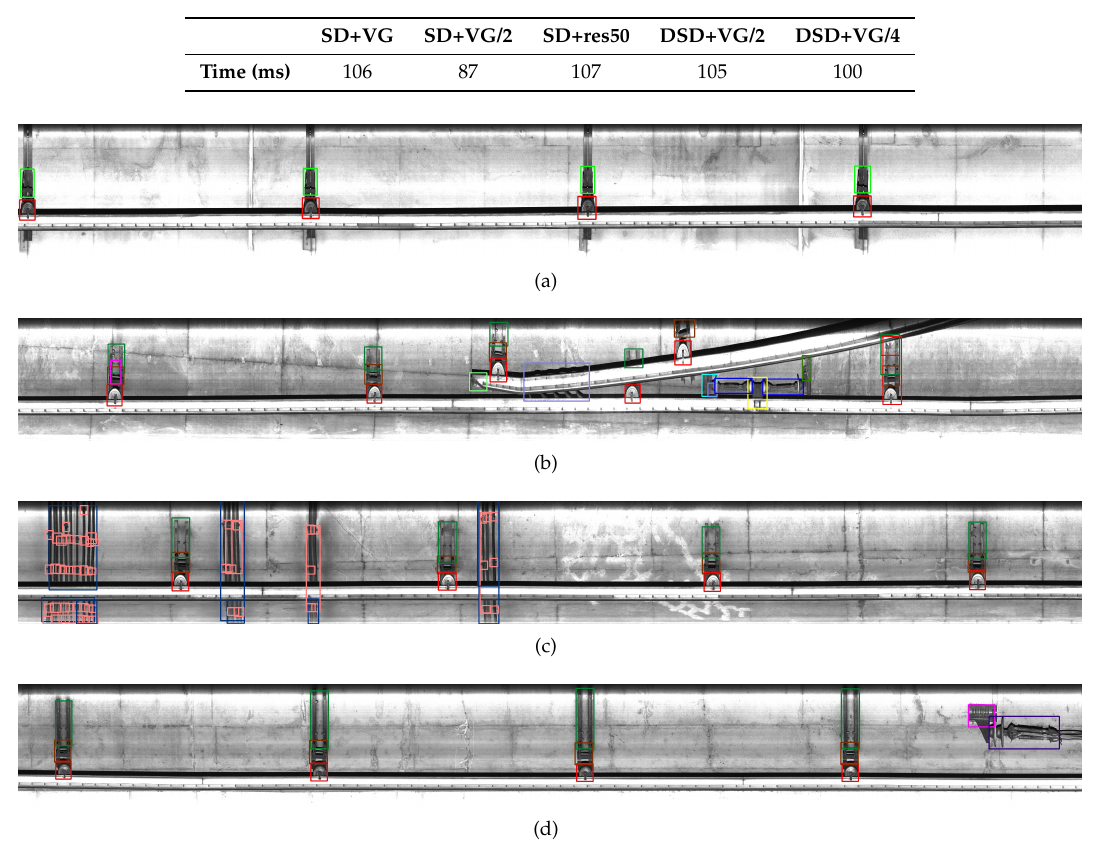
Table 3. Computational time of network models (ms).